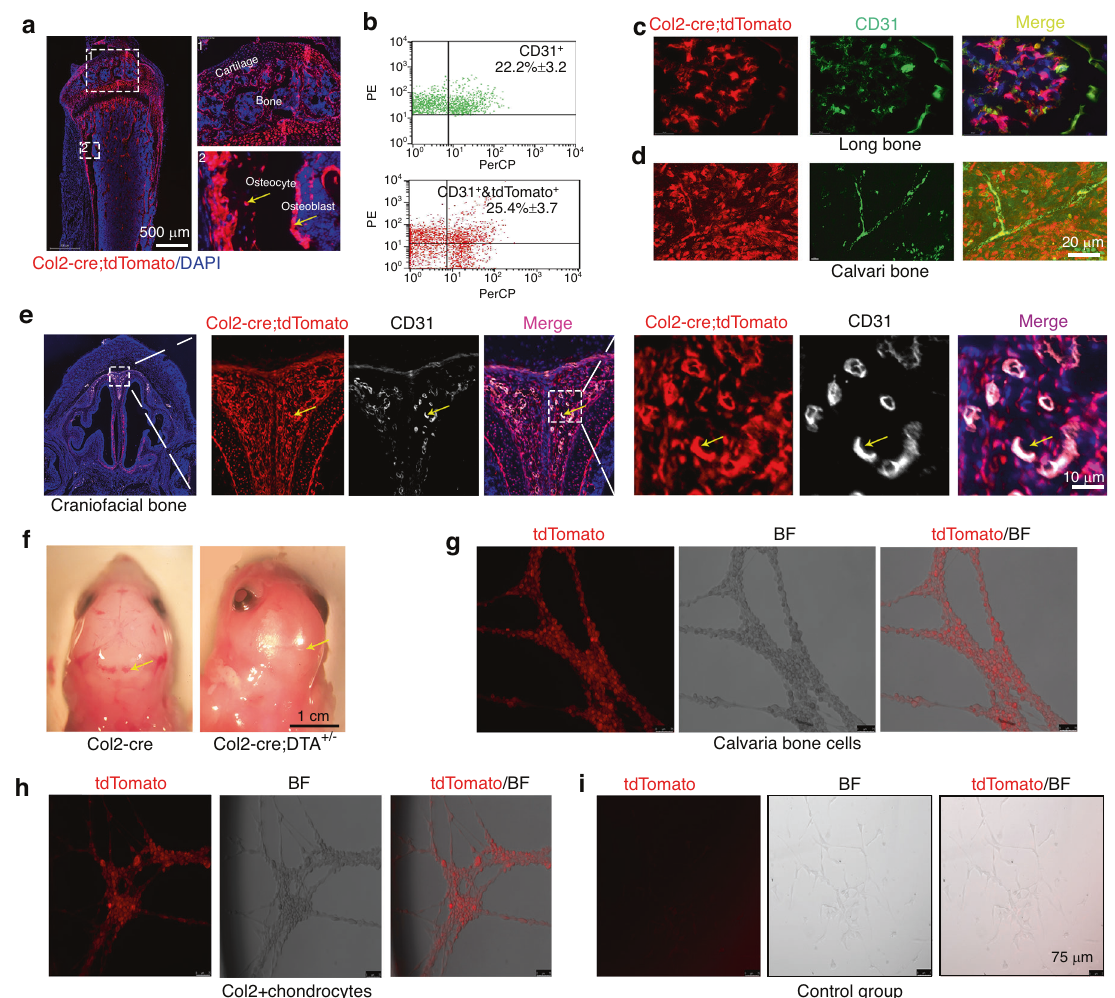
Fig. 6 Col2 + progenitors have multilineage differentiation ability, including CD31 + blood vessels. a Representative fl uorescent images of the distal femur showing that cartilage cells, osteoblasts and osteocytes are Col2 + . Yellow arrow, osteoblasts and osteocytes of 4-week-old Col2- cre;tdTomato mice. b Flow cytometry analysis was performed using dissociated long bone marrow cells collected from 4-week-old Col2-cre; tdTomato mice. Representative dot plots show that some Col2 + bone marrow stromal cells were CD31 + ( n = 3 mice per condition; three independent experiments). c Representative fl uorescent images of the distal femurs of 4-week-old Col2-cre;tdTomato mice showing that some CD31 + cells in long bones were Col2 + cells. d Representative fl uorescent images from the calvarial bone of 4-week-old Col2-cre;tdTomato mice showing that almost all CD31 + cells were Col2 + cells. e Representative fl uorescent images from the craniofacial bone of 4-week-old Col2- cre;tdTomato mice showing that almost all CD31 + cells were Col2 + cells. Yellow arrow, overlapping staining of blood vessels. f The gross appearance of the head of Col2-cre and Col2-cre;DTA + / − newborn mice. Note that the mutant mice showed a marked loss of blood vessels in the skull. Yellow arrow, blood vessels in each group. g Representative picture showing that Col2 + cells from the calvaria bone of Col2-cre; tdTomato mice exhibit tube formation capacity. h Representative picture showing that Col2 + cells from the cartilage of Col2-cre;tdTomato mice exhibit tube formation capacity. i Representative picture showing that Col2 − cells from the cartilage of Col2-cre;tdTomato mice do not have tube formation capacity. All the data are reported as the means ± s.ds. The statistical signi fi cance was determined by one-way ANOVA and Student ’ s t test. * P < 0.05, ** P < 0.01, *** P < 0.000 1. NS not statistically signi fi